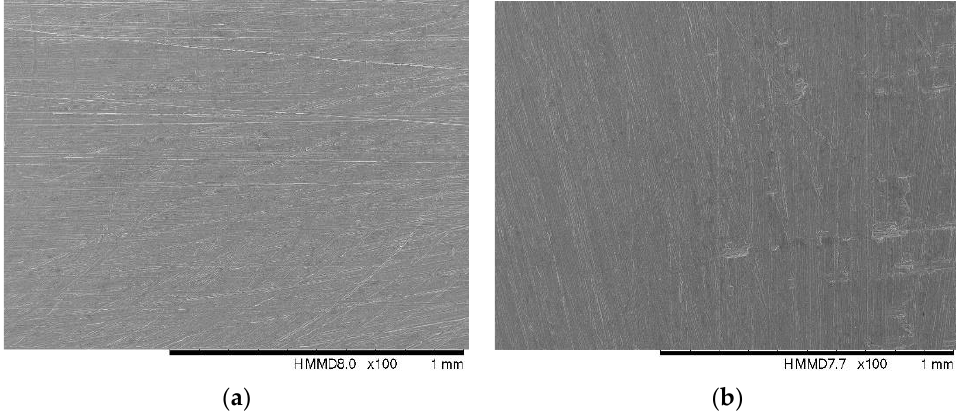
Figure 3. 2D SEM images: ( a ) HAp + Mg + Si_RT and ( b ) HAp + Mg + Si_200 coatings deposited on AZ31B substrates.